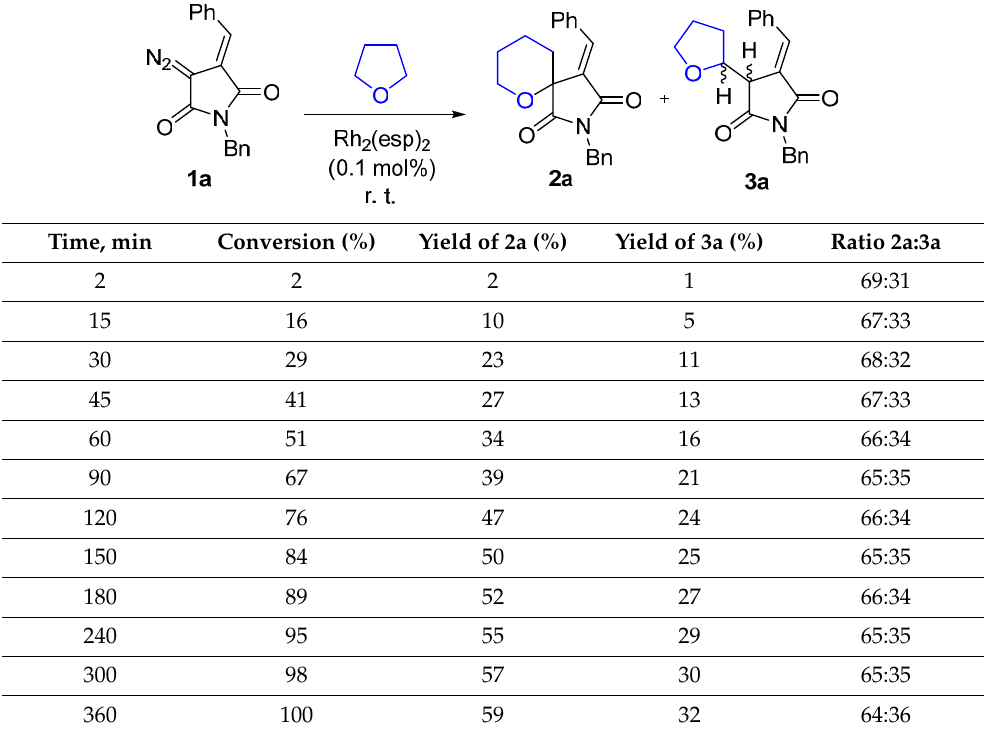
Table 1. Results of HPLC monitoring of reaction 1a → 2a + 3a .